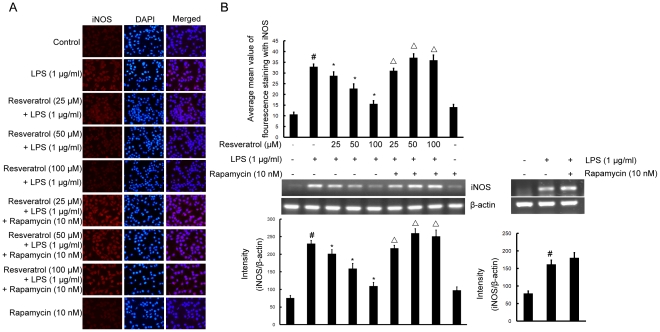
mTOR is required for resveratrol-inhibited expression of iNOS protein and mRNA induced by LPS in BV-2 cells.Panel A shows the immunofluorenscence images for protein expression of iNOS and Panel B shows the corresponding mRNA data. The relative mRNA level was quantified by scanning densitometry and normalized to β-actin mRNA. Note the up-regulated protein and mRNA expression of iNOS by LPS is suppressed by different concentrations of resveratrol; however, in cells pretreated with mTOR inhibitor rapamycin, the suppressive effect of resveratrol is abrogated. The values shown are mean ± SEM of data from three independent experiments. #Significant compared with control alone, p<0.05. *Significant compared with LPS alone, p<0.05. ▵Significant compared with resveratrol+LPS, p<0.05.